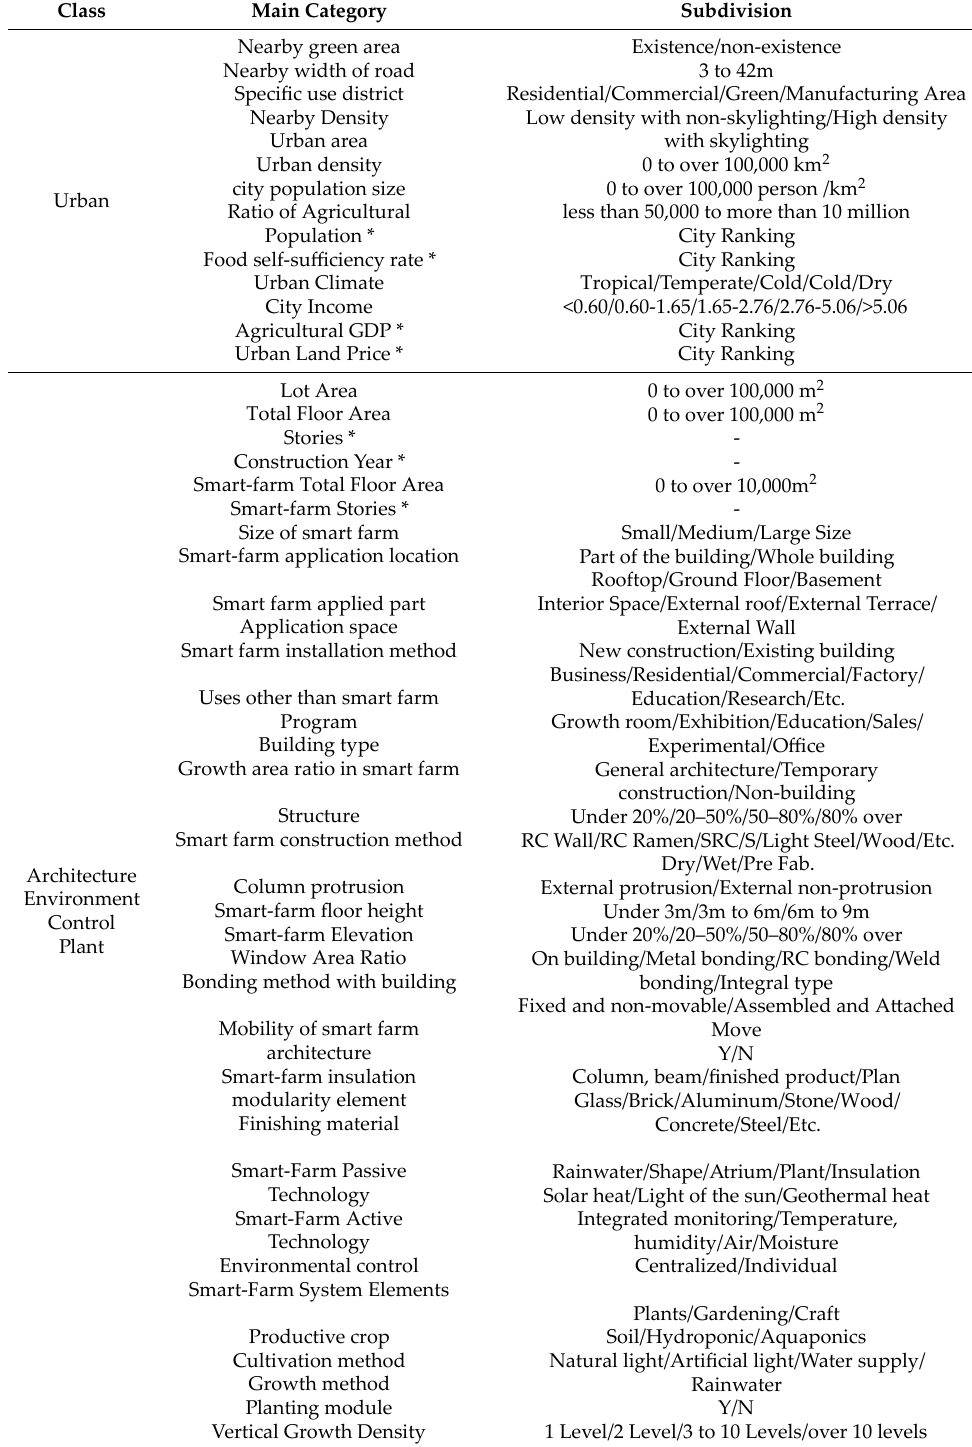
Table 1. Criteria for Classifying Smart Farm